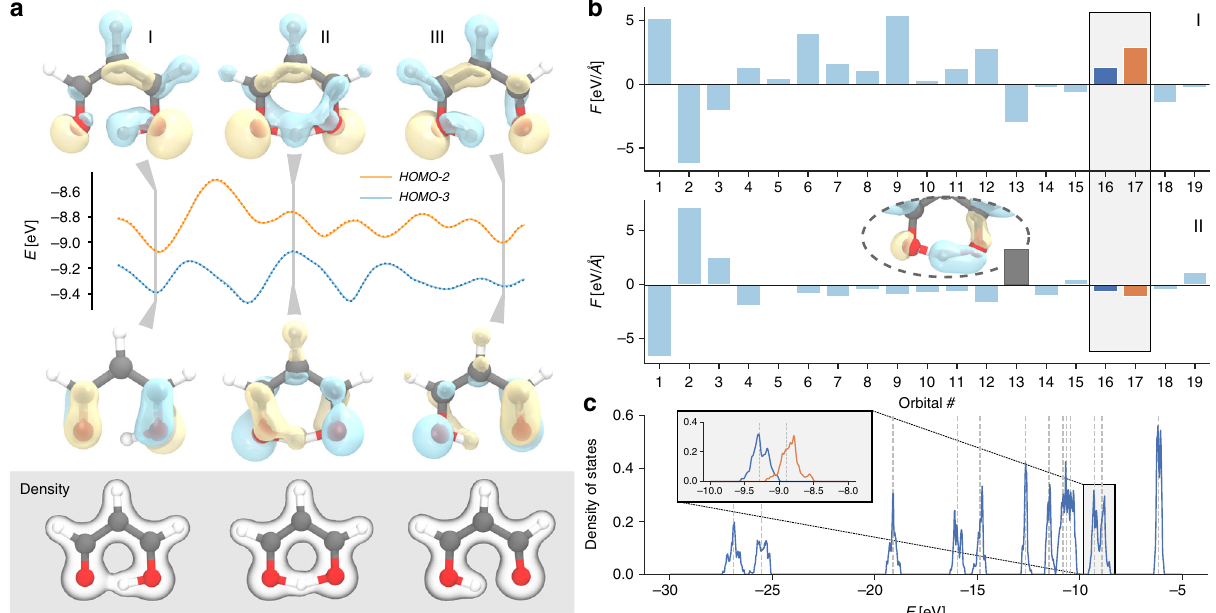
Fig. 3 Proton transfer in malondialdehyde. a Excerpt of the MD trajectory showing the proton transfer, the electron density as well as the relevant MOs HOMO-2 and HOMO-3 for three con fi gurations (I, II, III). b Forces exerted by the MOs on the transferred proton for con fi gurations I and II. c Density of states broadened across the proton transfer trajectory. MO energies of the equilibrium structure are indicated by grey dashed lines. The inset shows a zoom of HOMO-2 and